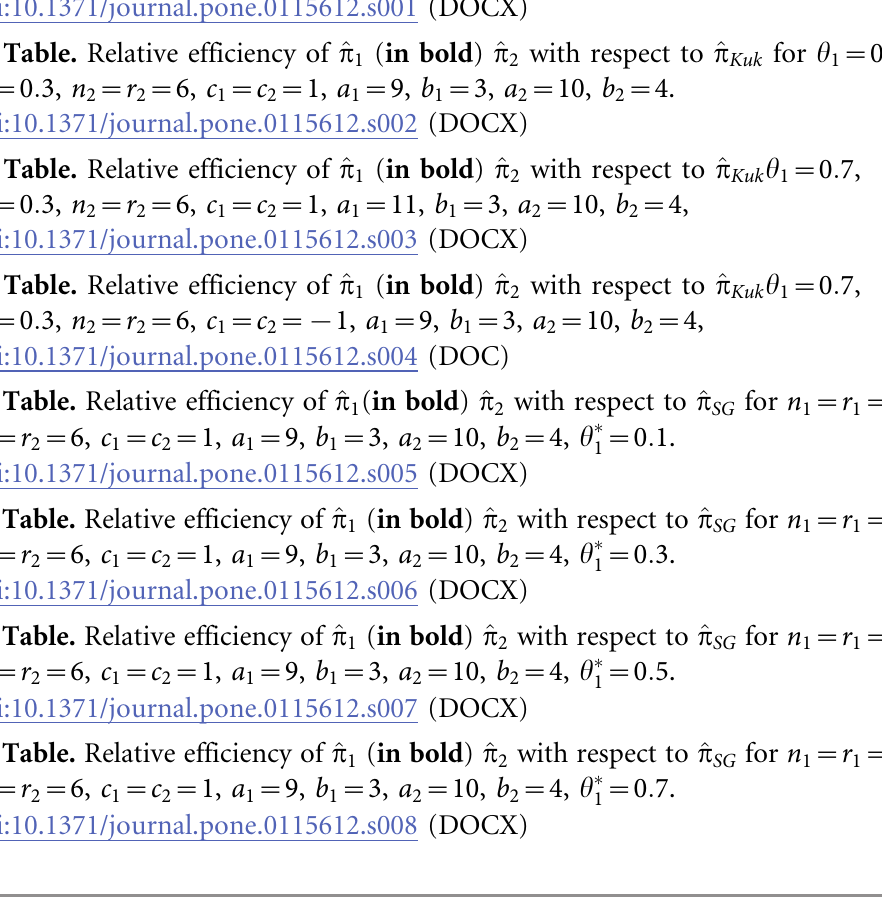
and RE values for h 1 2